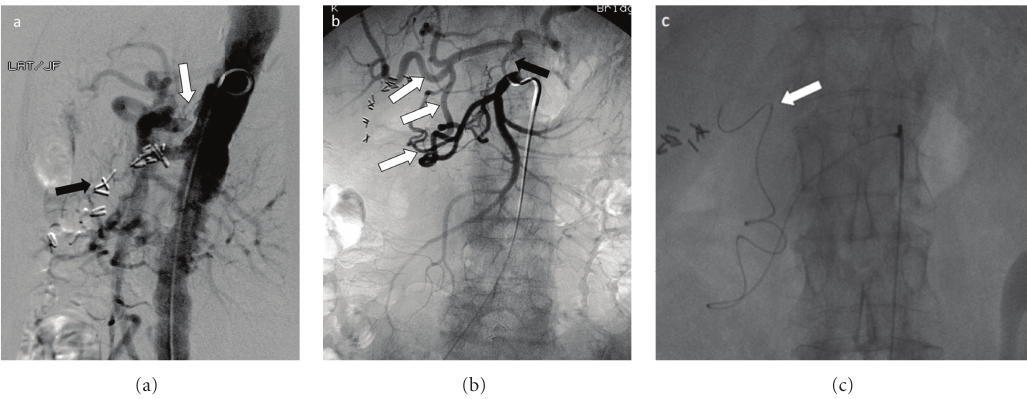
Figure 2: (a) Aortogram demonstrates a tight stenosis of the proximal celiac axis (white arrow) with mild poststenotic dilatation. In this case, the celiac artery stenosis was assumed to be related to atherosclerosis. The stenosis limits the access of the hepatic arterial branches for radioembolization purposes. Prior surgical clips related to partial right hepatic resection are noted (black arrow). (b) Superior mesenteric artery angiogram demonstrates significant hypertrophy and enlargement of the inferior pancreaticoduodenal arcade with opacification of gastroduodenal artery, and hepatic branches in a retrograde fashion (white arrows). There was a small collateral vessel which traveled from the superior mesenteric artery in a superior direction and opacified the very distal celiac axis and splenic artery (black arrow) likely representing the Arc of Buhler. (c) The right hepatic artery was not accessible through the tortuous pancreaticoduodenal collateral arcade (white